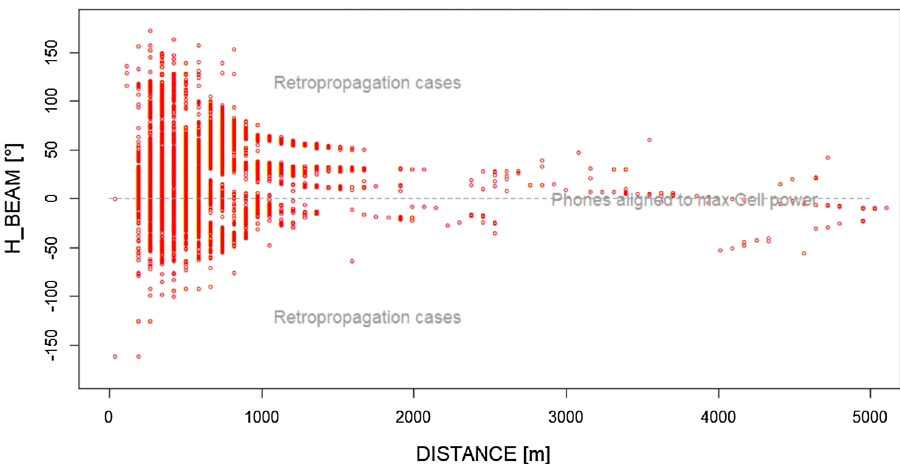
Figure 10. Angular distribution (H_BEAM) as a function of the electromagnetic distance of users from their serving BS cell, in the case of Sun-oriented BS cells during the two hours immediately before the 3rd July solar flare. The queues of the distribution (e.g., over + 100° and under −100°) are less populated with respect to the non-Sun-exposed BS cell equivalent queues (Fig. 11).